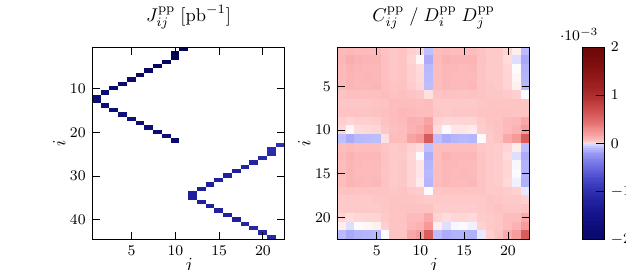
Fig. 8 The Jacobian matrix J pp for propagating the p+p uncertainties ij into R pPb uncertainties (cf. Eq. (15)) and the experimental (excluding overall normalization uncertainty) covariance matrix C pp for the p+p ij W ± measurement at 8.0 TeV. Indices i , j in C pp and the index j in J pp ij ij followtheorderingofthedatapointsinFig.7,withtheindices1through 11 corresponding to the W − production and 12 through 22 to W + , and the index i in J pp follows the ordering in Fig. 9, with the indices 1 ij through 22 corresponding to the W − production and 23 through 44 to W +